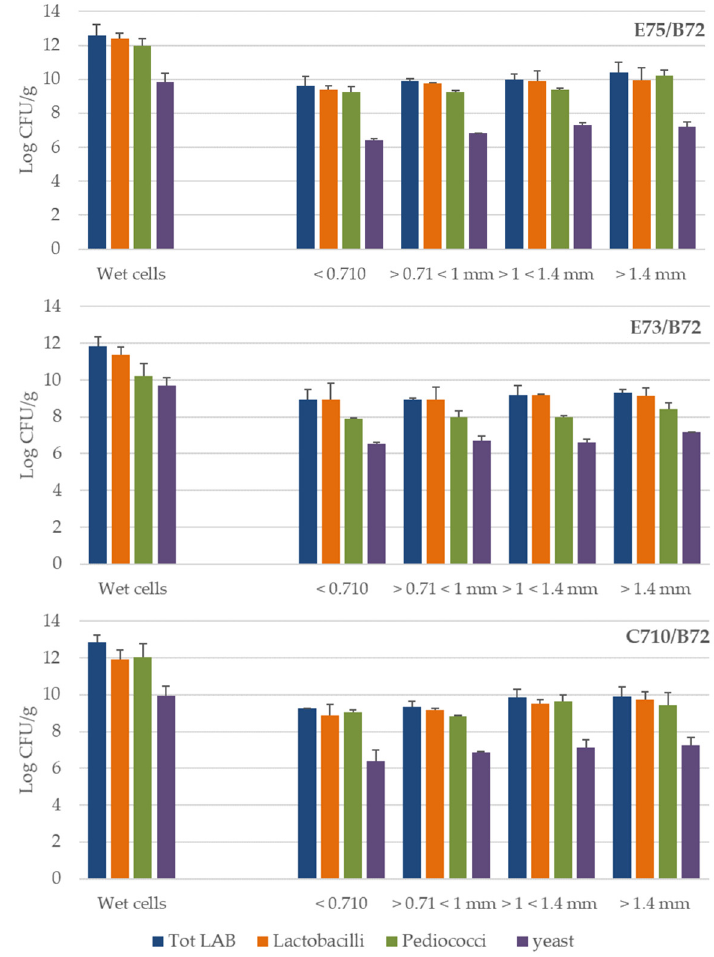
Figure 1. Survival of LAB and yeast after wet granulation compared with the initial population level (wet cells) for each granules’ size <0.710, 0.710–1, 1–1.4, and >1.4 mm. Analyses were performed in triplicate. Results are reported as mean values ± SD.